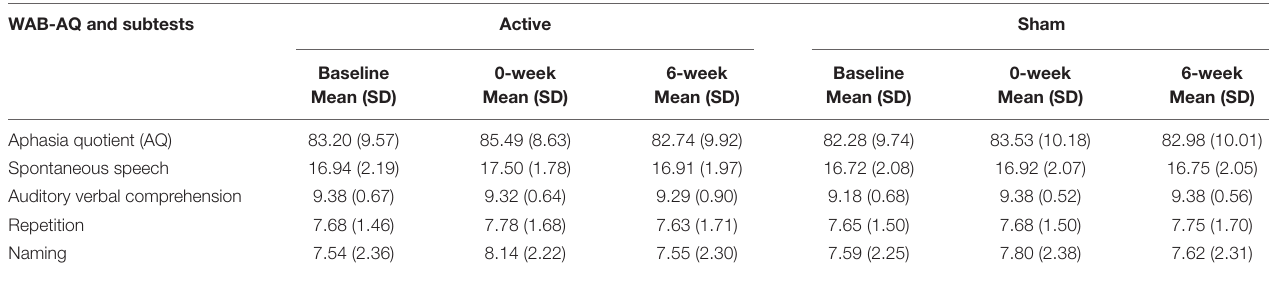
TABLE 2 | Summary of means and standard deviations (SD) on the WAB-AQ and WAB